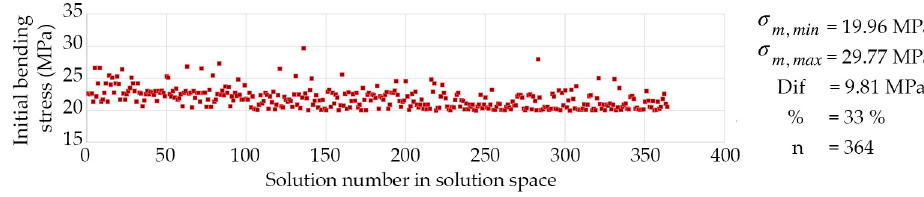
Figure 19. Evolution of initial bending stress for 50 × 25 mm 2 cross-section in Step 1.